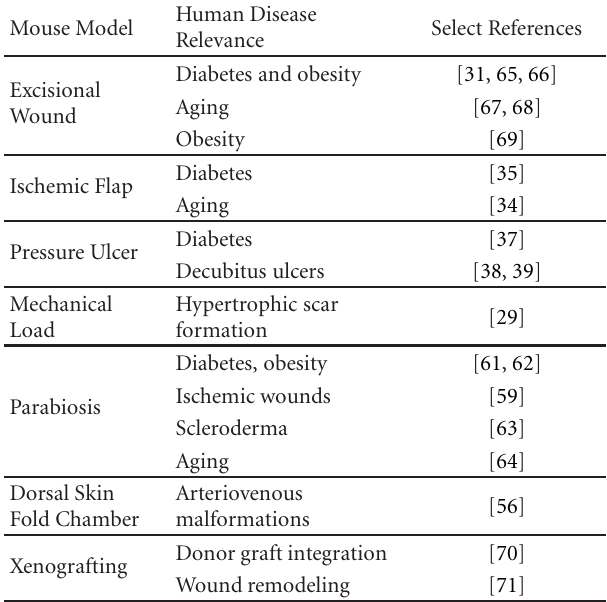
Table 2: Surgical mouse models of cutaneous disease with select